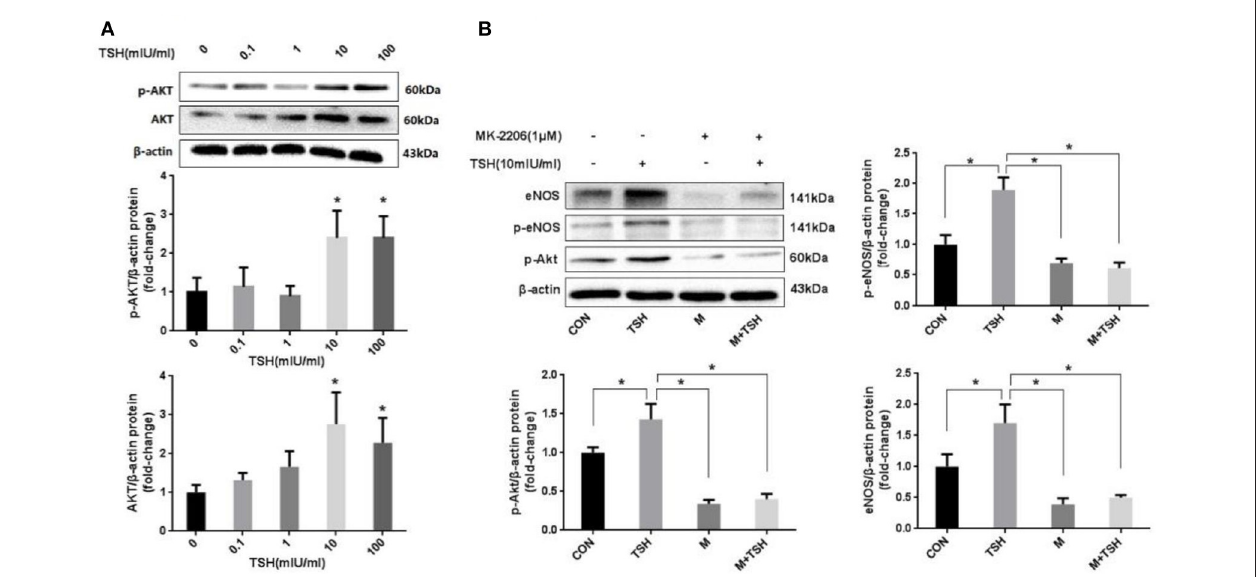
FIGURE 5 | Role of Akt in the induction by TSH of eNOS in HUVECs. (A) Protein expression of Akt in HUVECs stimulated by different concentrations of TSH (0, 0.1, 1, 10, and 100 mIU/ml) for 24h; (B) Inhibition of Akt: HUVECs were pretreated with 1 µ M of MK-2206 for 6h or not, and then together with or without TSH (10 mIU/ml) for 24h. Data were obtained from three separate experiments. HUVECs without stimulating with TSH (0 mIU/ml) served as control; M represented MK-2206; * P < 0.05, when compared with the control.